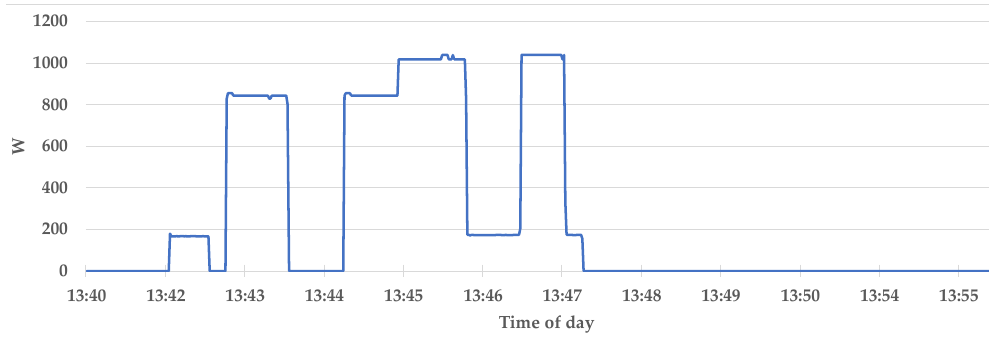
Figure 16. Combined profile of the lamp and of the electric heater.